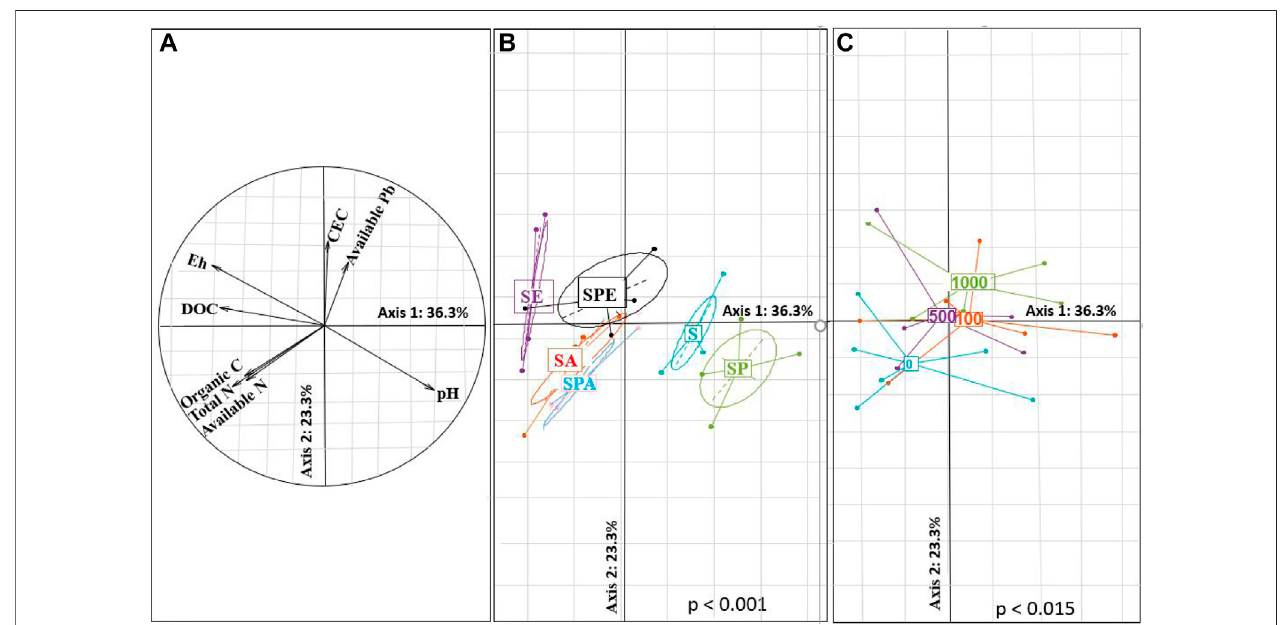
FIGURE 3 | Principal component analysis of soil characteristics in the different treatments. (A) : Correlation circle of the soil properties; projection of experimental points according to treatments; (B) Treatments with or without earthworms. (C) Treatments at different Pb contamination levels of 0, 100, 500, and 1,000 mg · kg -1 Pb. DOC: dissolved organic carbon; CEC: cation exchange capacity. S: without plant or earthworm, SP: Brassica campestris was grown, SA: Amynthas aspergillum was inoculated, SE: Eisenia fetida wasinoculated, SPA: B. campestris wasgrown and A. aspergillum wasinoculated , SPE: B. campestris wasgrown and E. fetida was inoculated.